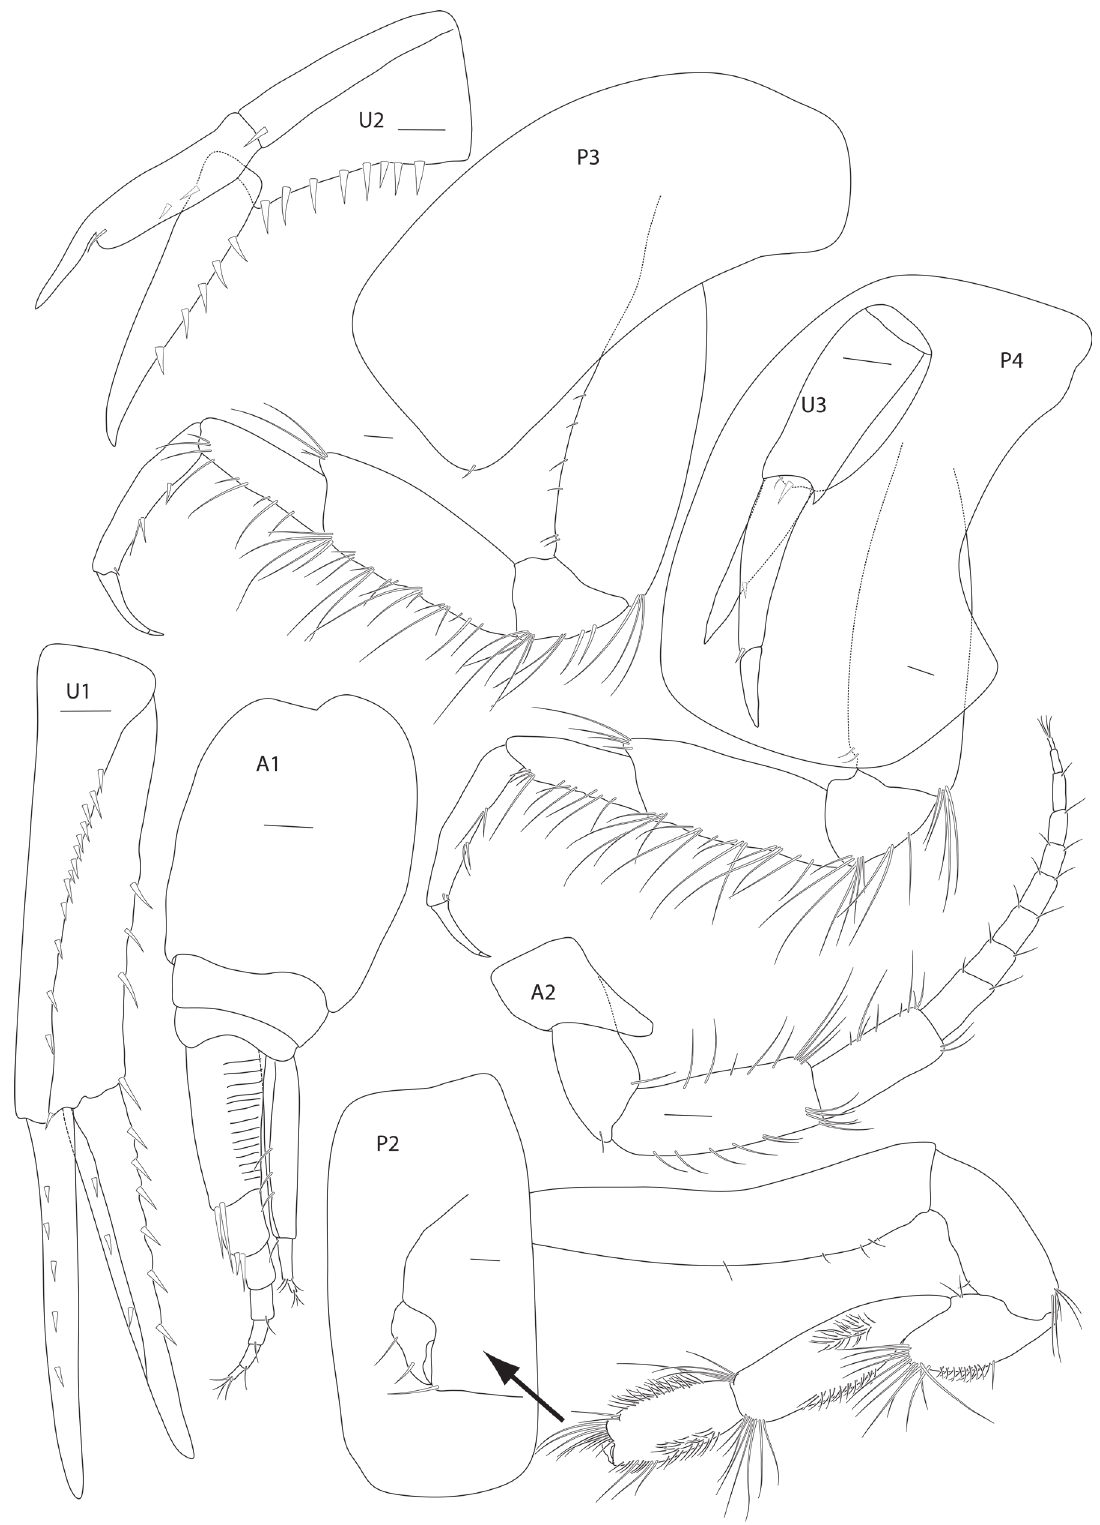
Fig. 2. Onisimus normani Sars, 1890, ♀, 10 mm, Korsfjorden, Norway (TSZCr8659). Pereopods 2, 3 and 4, uropods 1, 2 and 3, antenna 1 and 2. Abbreviations: see Material and methods. Scale bars = 0.1